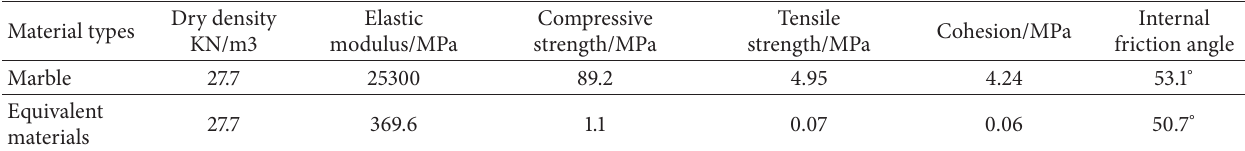
Figure 5: Equivalent materials and mechanical experiments: (a) the mould; (b) sample of equivalent materials; (c) sample preparation; (d) maintenance of the sample; (e) uniaxial compressive test of sample; (f) shearing test of the sample. Table 3: Physical and mechanical parameters of the prototype and